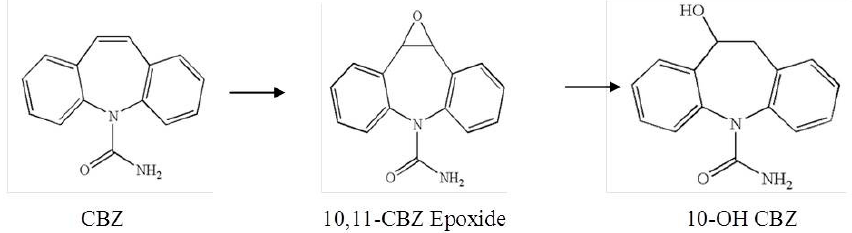
Figure 7. Proposed oxidation reaction of CBZ by A. braunii and the formation of 10-OH CBZ.